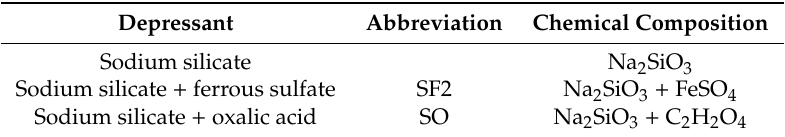
Table 1. Depressants used in this